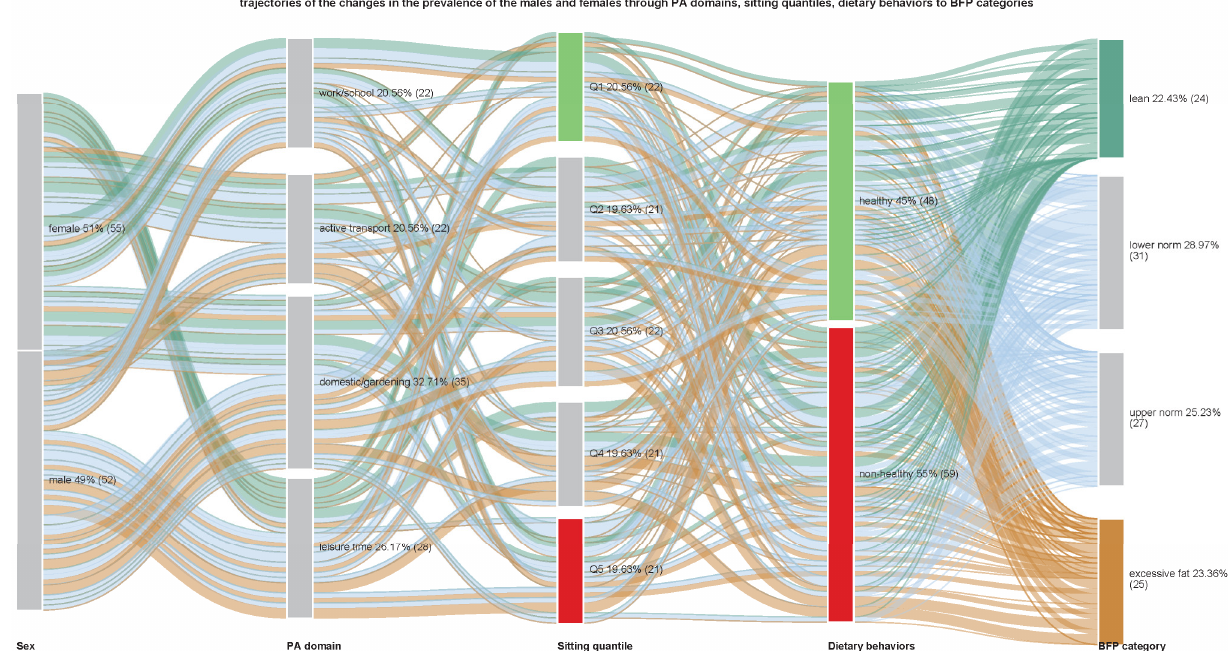
Figure 3. Sankey diagram of the trajectories of the relationship between dominant physical activity domains, sitting time quintiles, and healthy and unhealthy dietary behaviors, with corresponding body fat percentage categories, based on the prevalence of the participants. The width of the links is proportional to the number of individuals.